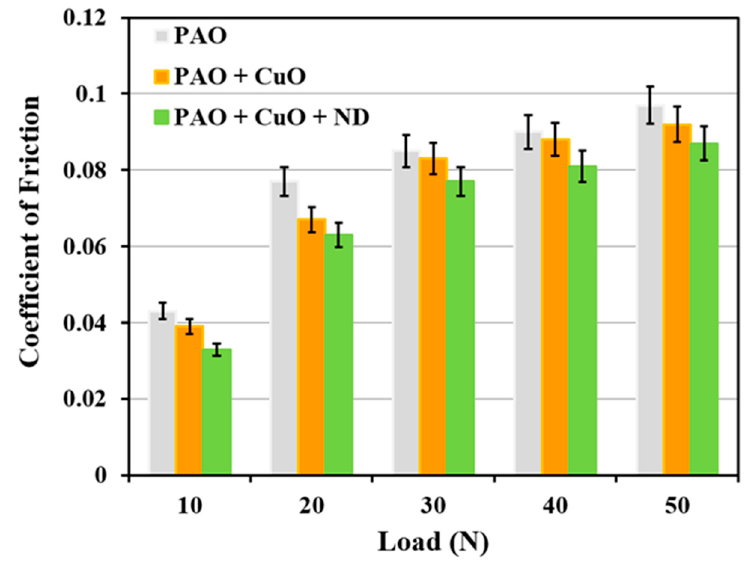
Figure 14. Coefficient of friction of the steel–aluminium tribopair with PAO base oil, PAO + CuO and PAO + CuO + ND nanolubricants, with increase in applied load from 10 N to 50 N. Under PAO + CuO lubrication, COF reduces when compared to that under lubrication by PAO base oil at all loads (Figure 14). During sliding, CuO nanoparticles form tribofilm on disc surface (Figure 5) and the tribofilm prevents direct metal-to-metal contact between the tribopair and reduces the friction property [10]. Average steady state COF values of the tribopair in the presence of PAO base oil, PAO + h-BN and PAO + h-BN + ND nanolubricants for applied loads 10 N to 50 N are shown in Figure 15. Under PAO + h-BN lubrication, COF reduces when compared to that under lubrication by PAO base oil at all loads. h-BN nanoparticles have a layered structure, similar to graphite, MoS 2 and WS 2 solid lubricants, with strong covalent bonds between their molecules in each layer and weak van der Waals bonds between the layers [14,24,25,31]. Under external shear force, such as that during sliding under an applied load, easy shearing takes place between the layers along the basal plane of h-BN structure, and the material becomes smeared onto the disc surface as a tribofilm (Figure 9). This occurrence causes a reduction in the COF [14,24,25].